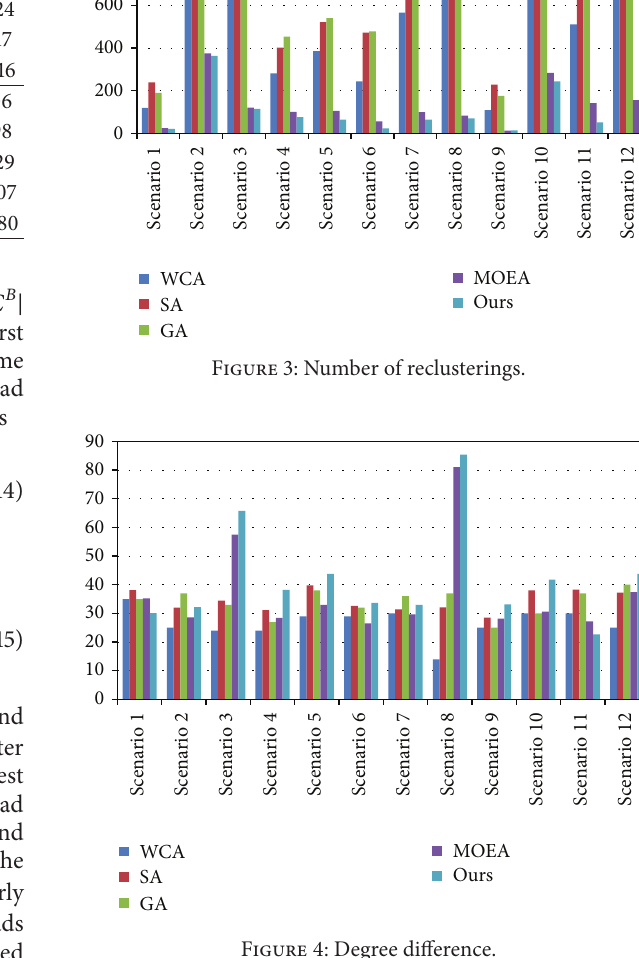
Figure 4: Degree